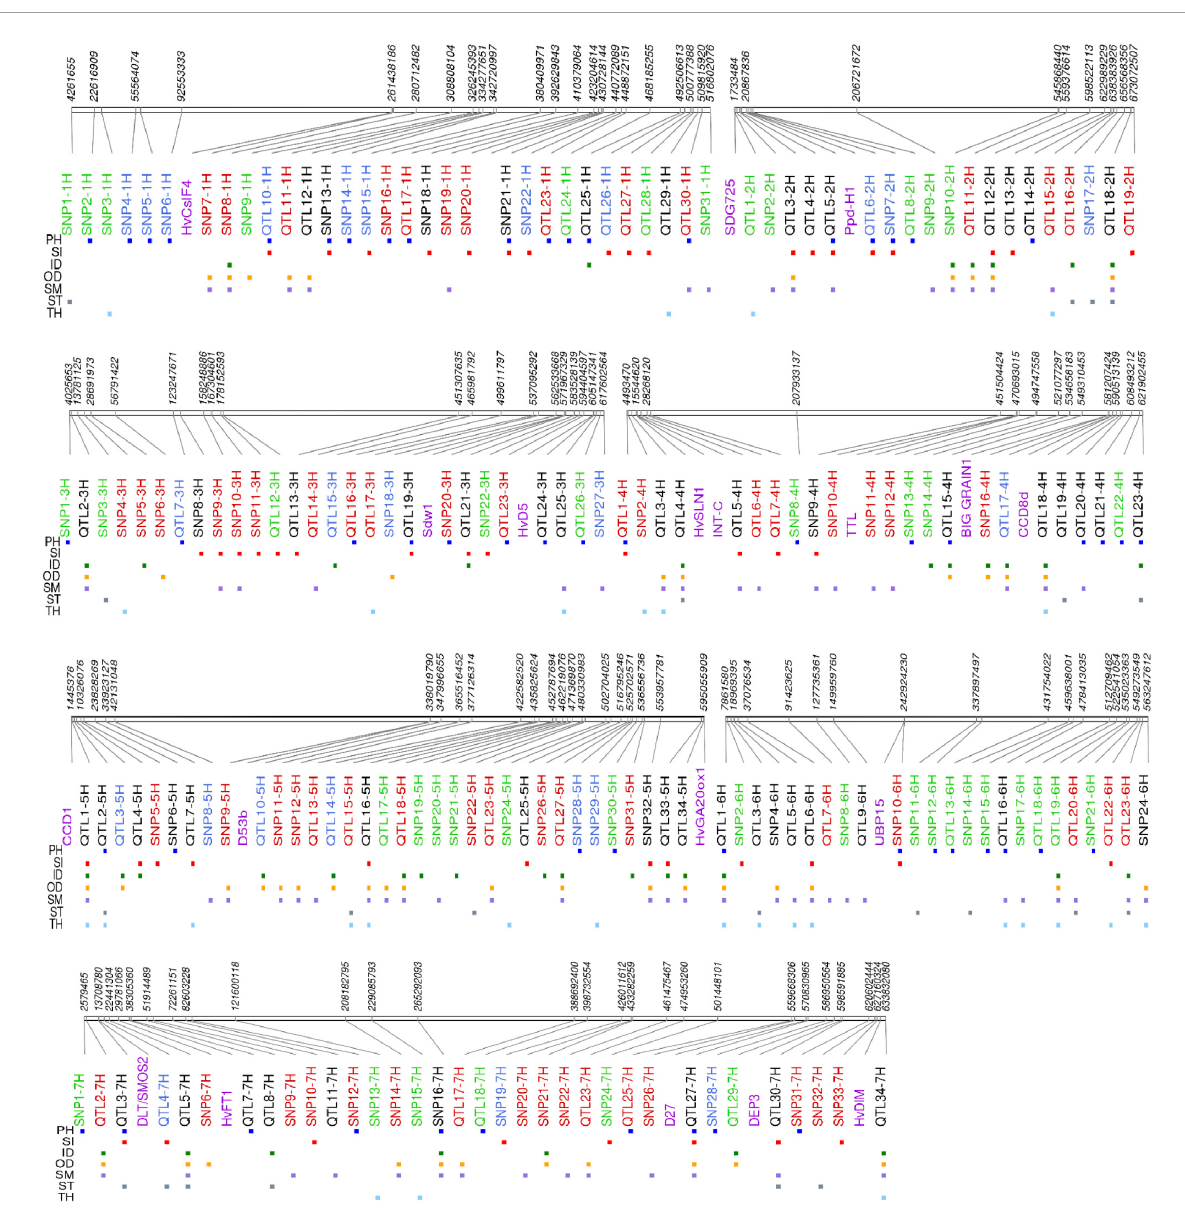
FIGURE4 Physical map of 192 QTLs associated with culm morphological traits a cross whole panel and the row type subsets. Loci with red, blue, and green colors are unique to whole panel, two-row, and six-row subsets, respectively. Loci with black color are those detected at least in two association panel. Purple color indicates relative position of barley known genes at that particular genomic region. PH, plant height; OD, outer diameter; ID, inner diameter; TH, thickness; SM, section modulus; ST, stiffness; SI, stem